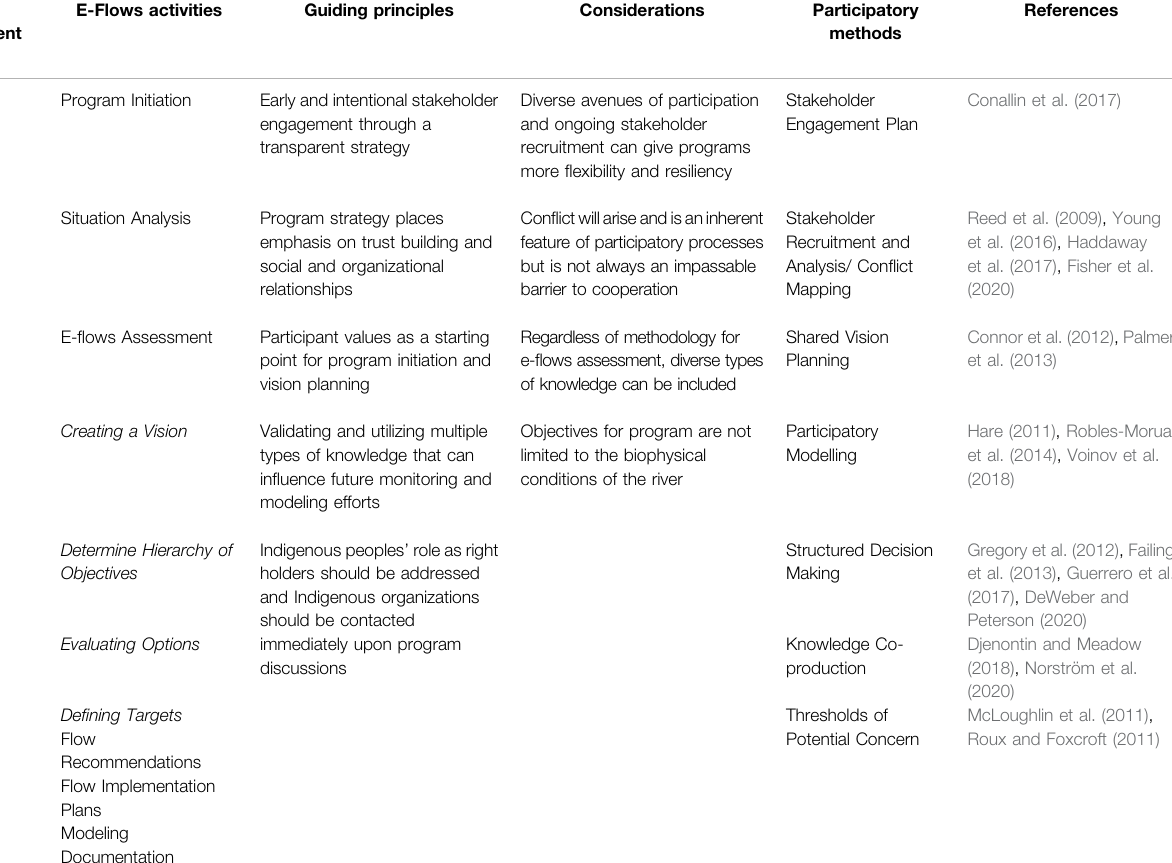
TABLE 3 | Role and form of participation across the adaptive management